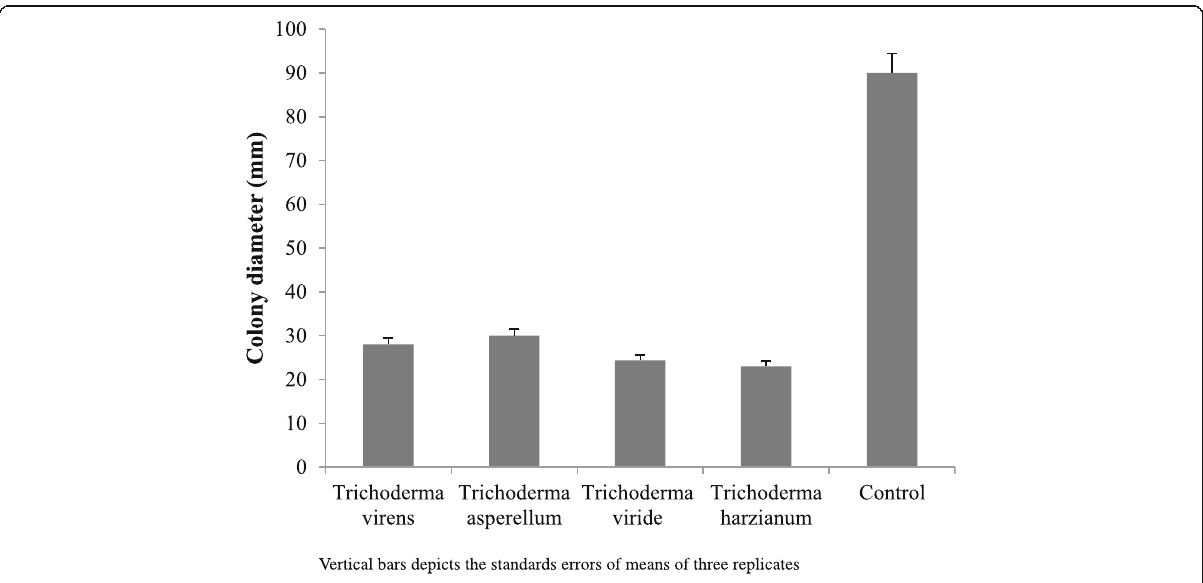
Fig. 1 Effect of the tested bioagents on the mycelial growth of Rhizoctonia bataticola